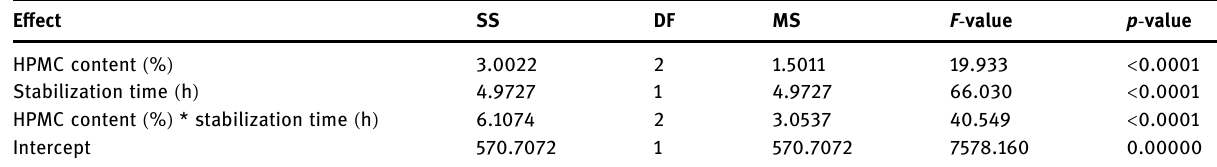
Table 11: Analysis of variance ( ANOVA ) for compressive strength results of mortars with 48 and 72 h of stabilization E ff ect SS DF MS HPMC content ( % )